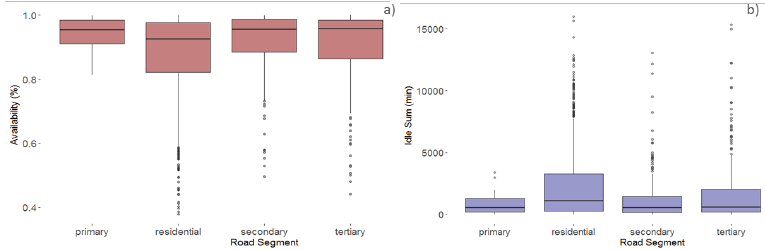
Figure 7. Boxplot of availability ( a ) and idle time ( b ) per road segment.